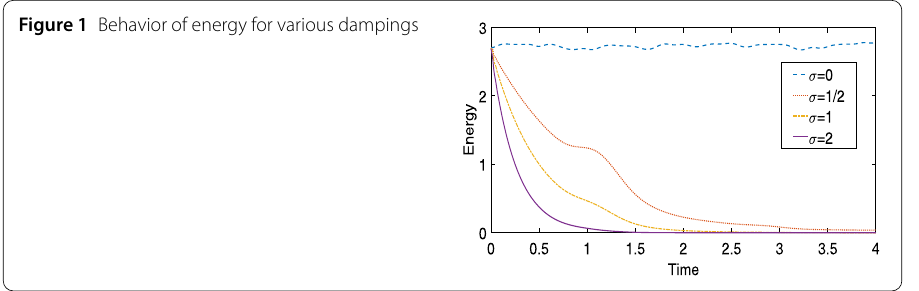
Figure 1 Behavior of energy for various